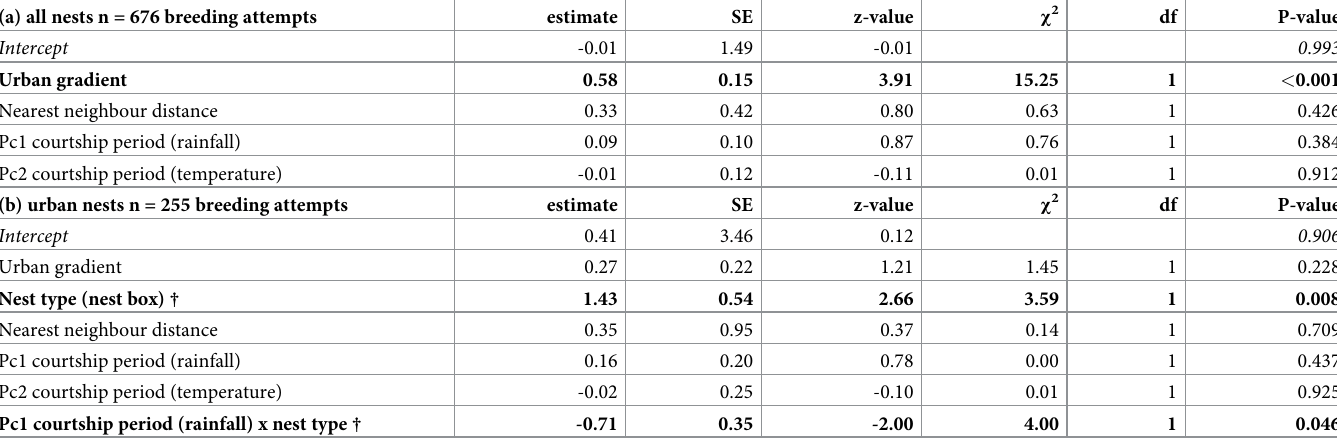
Table 1. Generalized linear mixed effects model for breeding probability in relation to (a) the urban gradient (1–78% urban cover); and (b) nest type (nest boxes versus other), nearest neighbour distance (log transformed) and weather conditions during the courtship period (winter). Annual breeding attempts of 59 and 26 peregrine terri- tories, respectively, over 26 years (1989–2014) on the Cape Peninsula. Significant estimates indicated in bold.